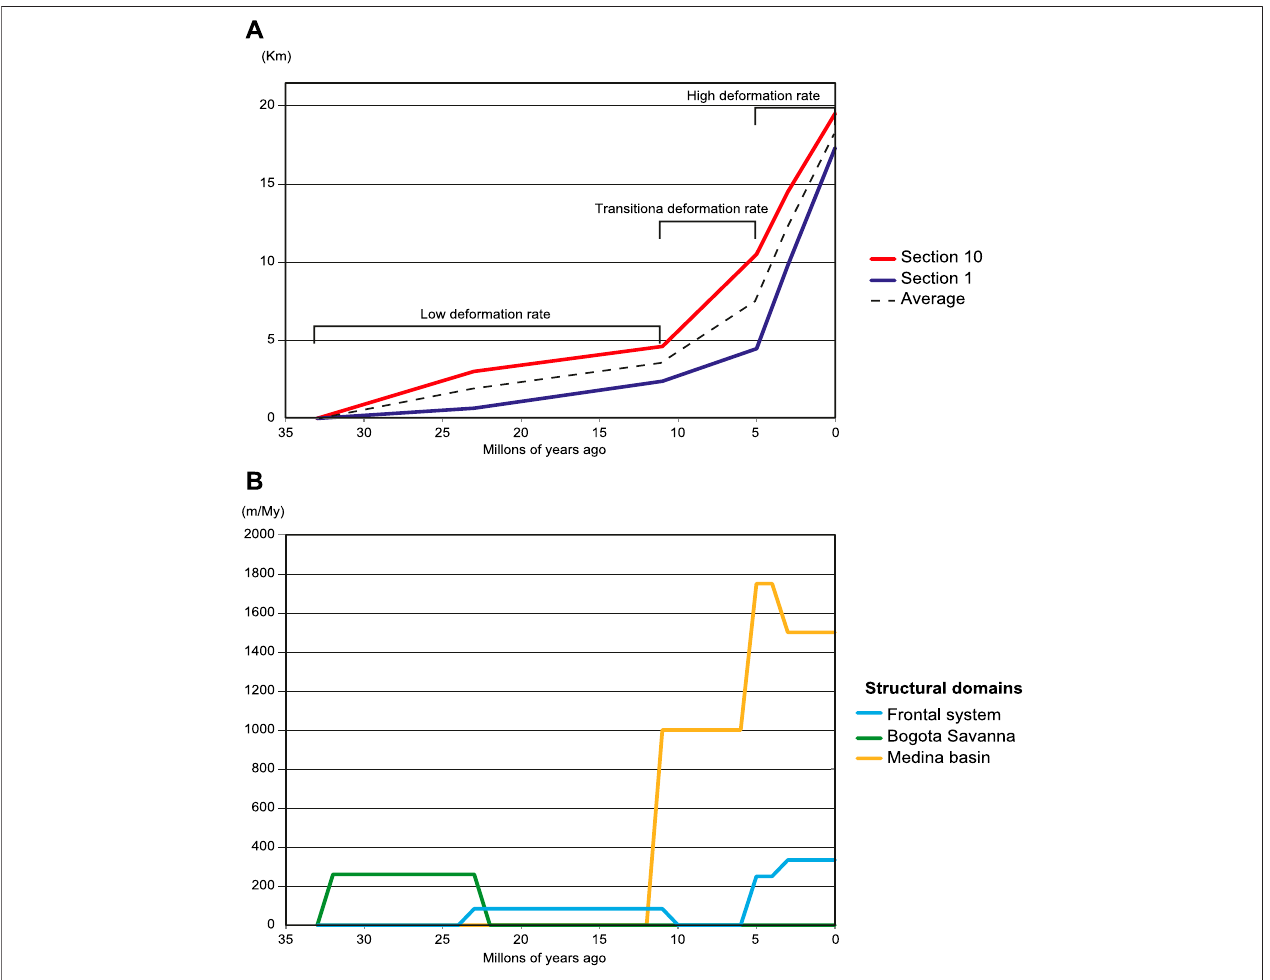
FIGURE 17 | Deformation analysis in the study area. (A) Accumulative shortening for both sections. (B) Shortening rates in different structural domains of Section 10.